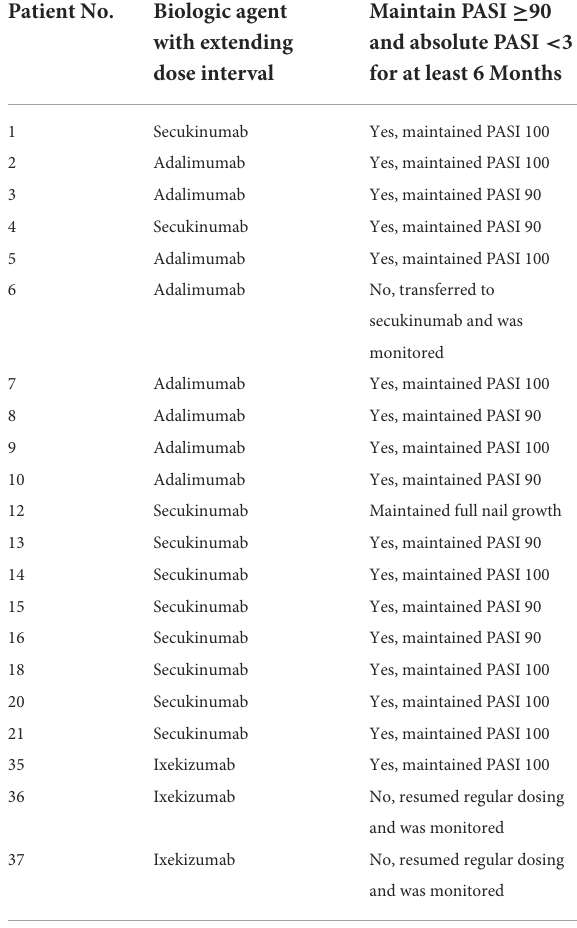
TABLE 4 Extending the dose interval: detailed patient data. Patient